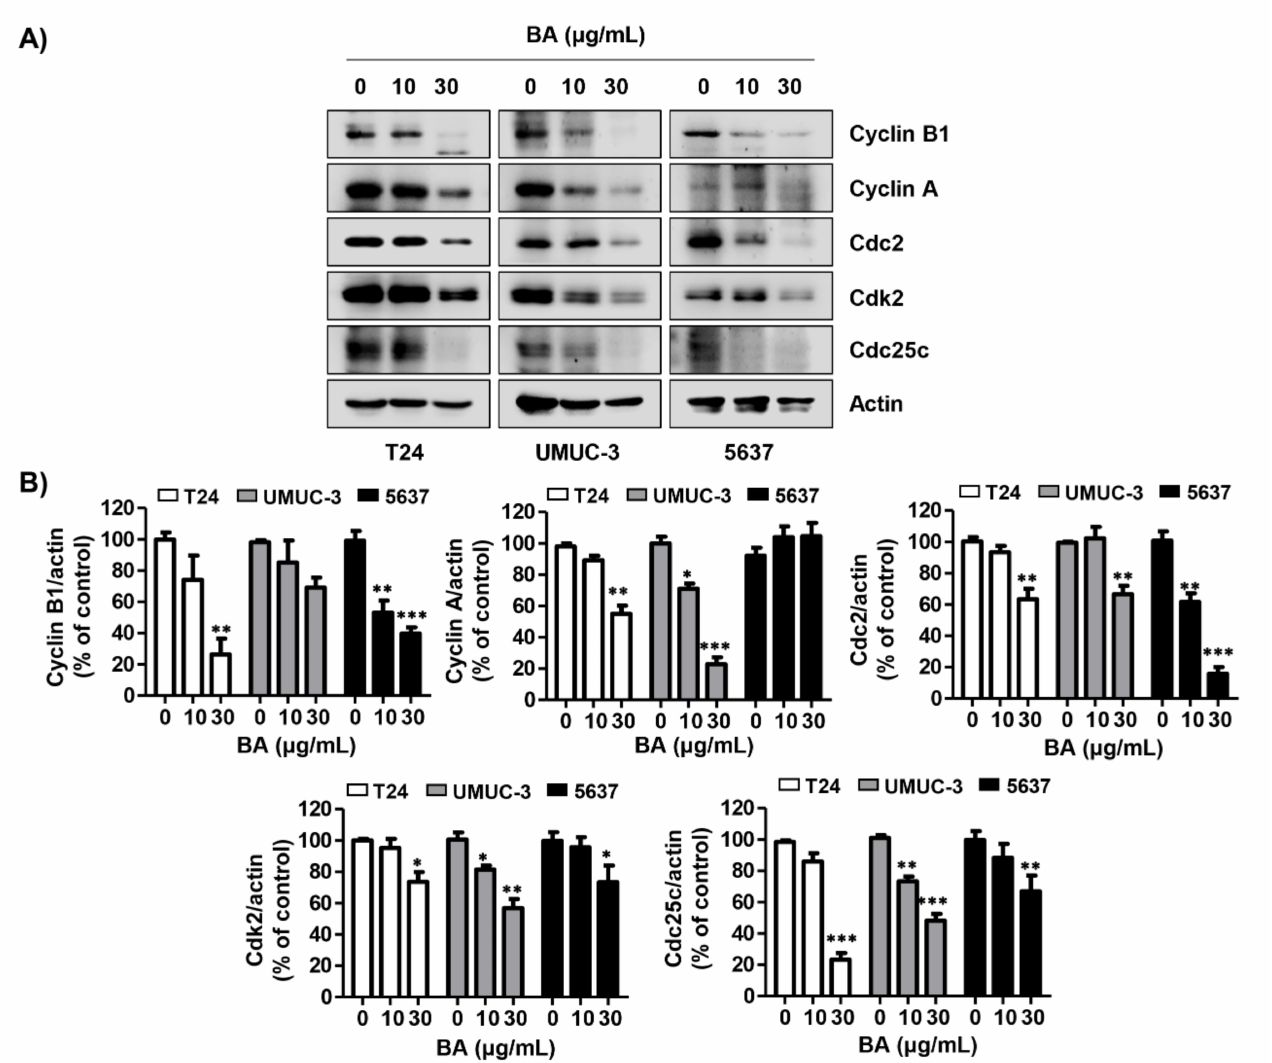
Figure 3. BA regulates the expression of G2/M phase-associated proteins in human bladder cancer cells. Cells were treated with BA (0, 10, and 30 µ g/mL) for 48 h. ( A ) The G2/M phase-associated proteins (cyclin B1, cyclin A, Cdc2, Cdk2, and Cdc25c) were detected by Western blotting. Actin was used as a loading control. ( B ) Bar graphs indicate the relative band density in western blot analysis ( n = 3). * p < 0.05, ** p < 0.001, and *** p < 0.0001 vs. untreated control